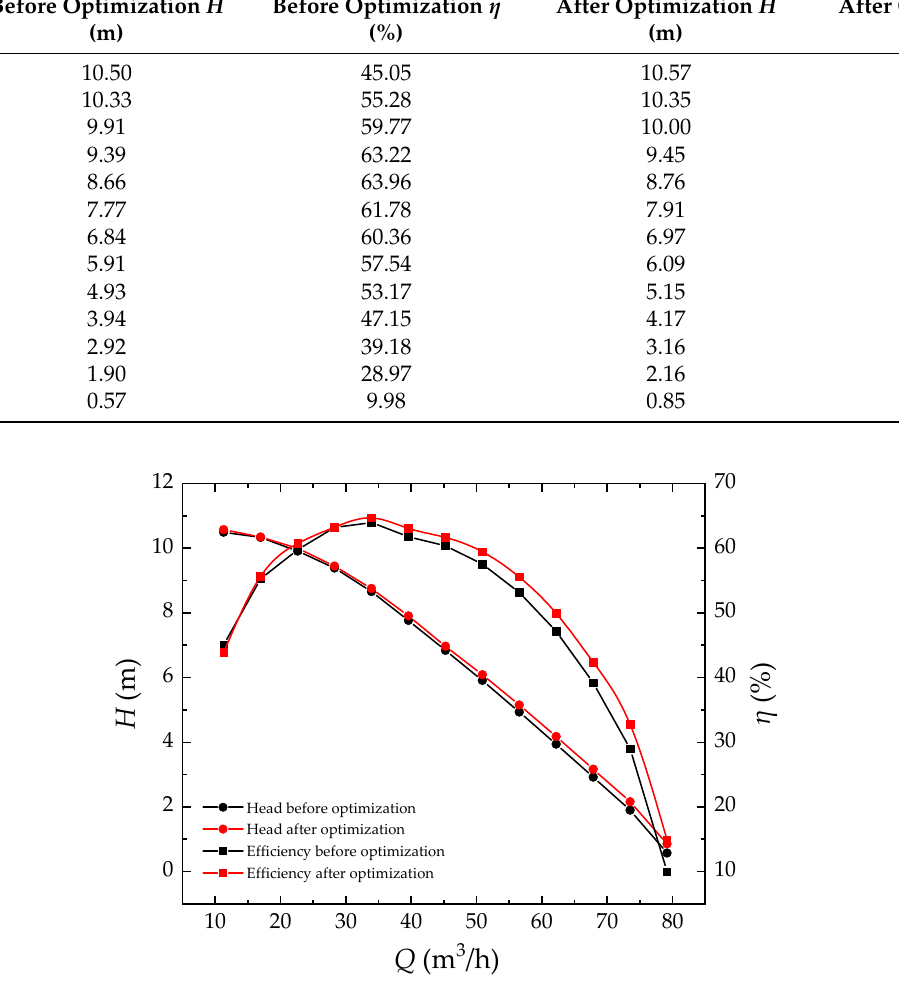
Figure 8. Comparison of energy characteristics before and after optimization.